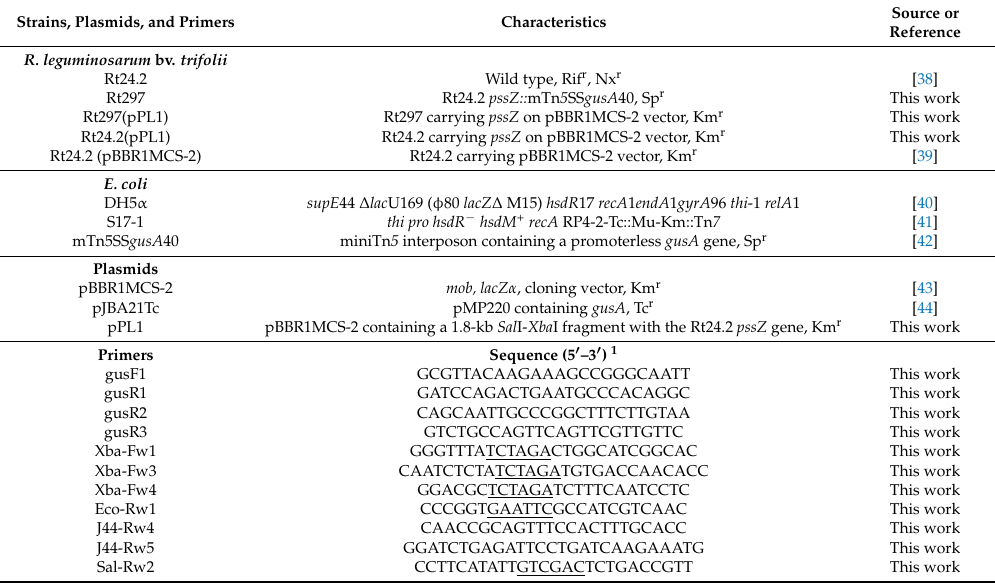
Table 1. Bacterial strains, plasmids, and oligonucleotide primers used in this study. Strains, Plasmids, and Primers Characteristics Source or Reference R. leguminosarum bv. trifolii